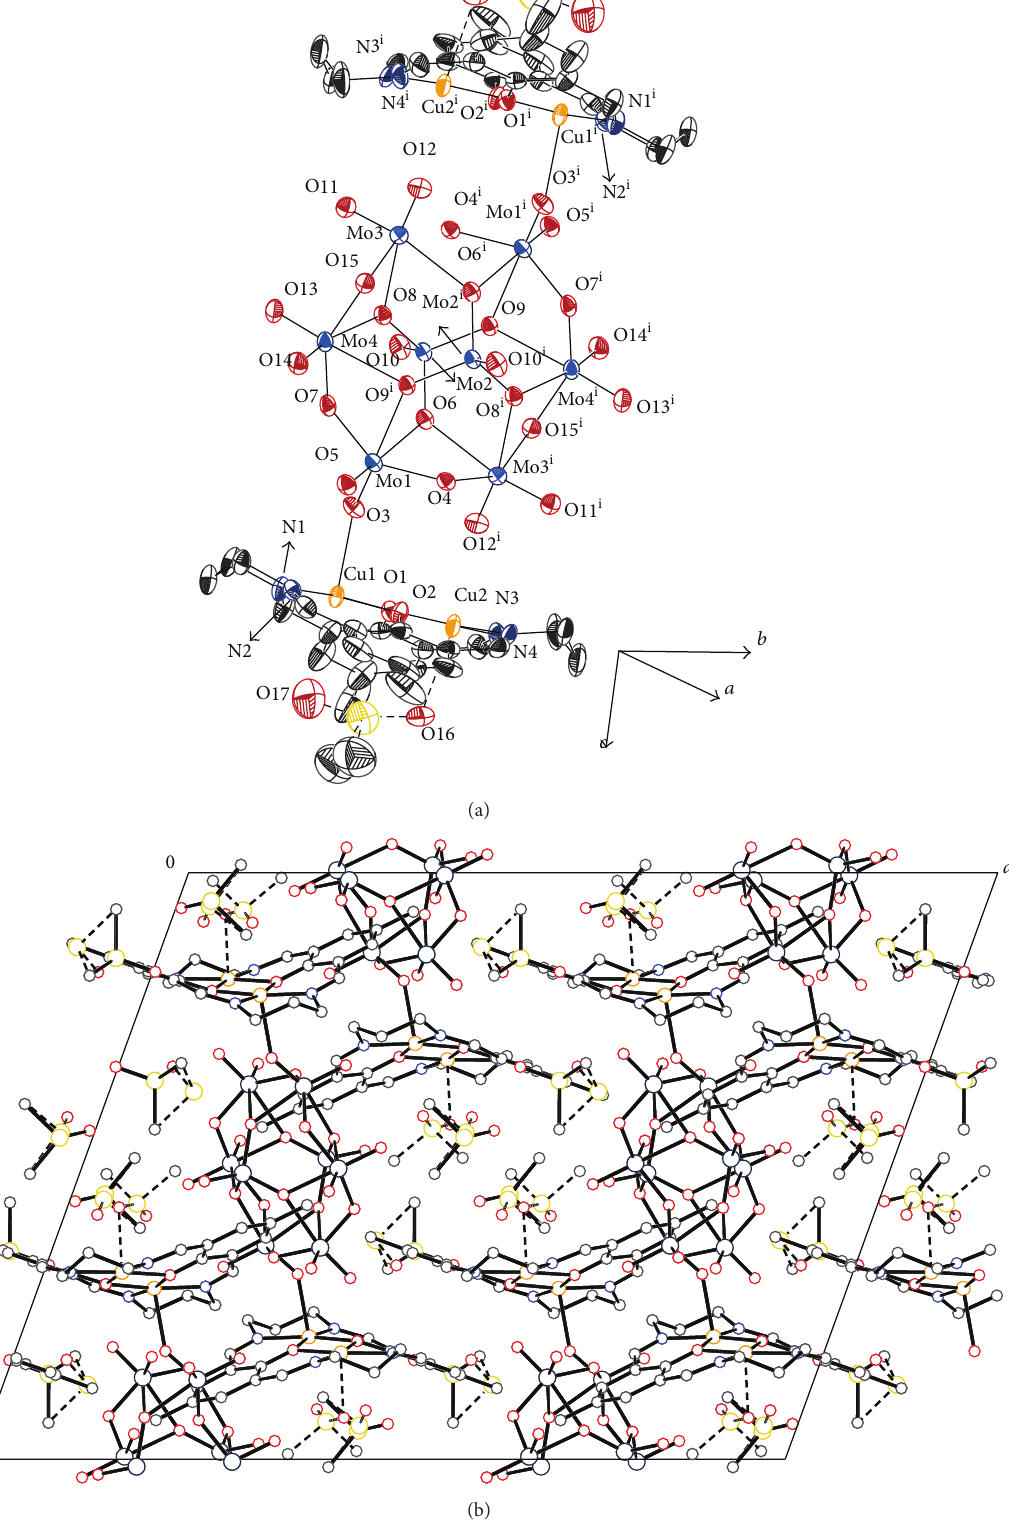
Figure 3: (a) Molecular structure with the atom-labeling scheme. Ellipsoids are drawn at 50% probability level. The dmso and the hydrogen atoms were omitted for sake of clarity. (b) Packing of complex 2 along the b -axis the hydrogen atoms were omitted for sake of